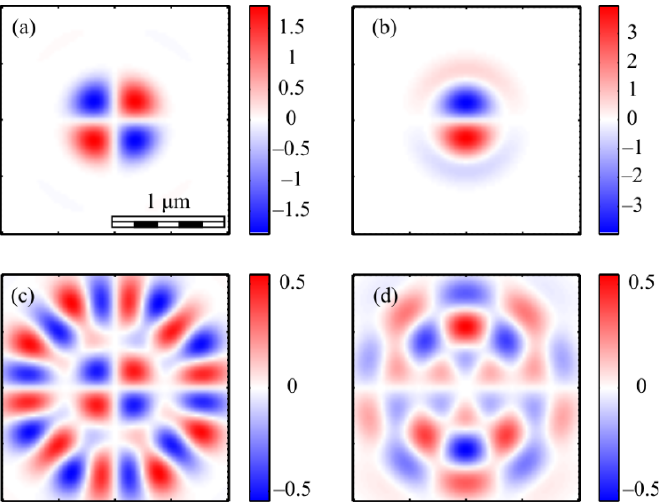
Figure 11. The Stokes vector components s 2 ( a , c ) and s 3 ( b , d ) of the focused vector field (1) with m = 1 (a,b) and m = 5 (c,d).